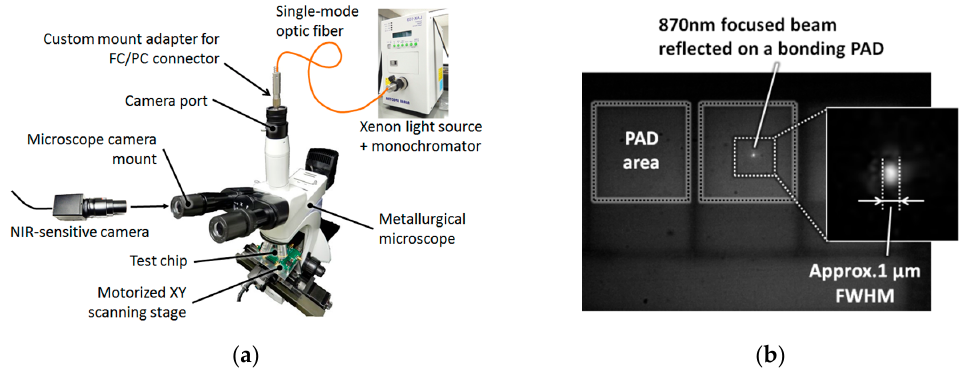
Figure 4. ( a ) Measurement system for high-resolution XY mapping of the photon response of a SPAD at any desired optical wavelength. An objective lens with an NA of 0.6 and ×40 is used in the microscope; ( b ) Image captured using an NIR-sensitive camera mounted on one of the microscope